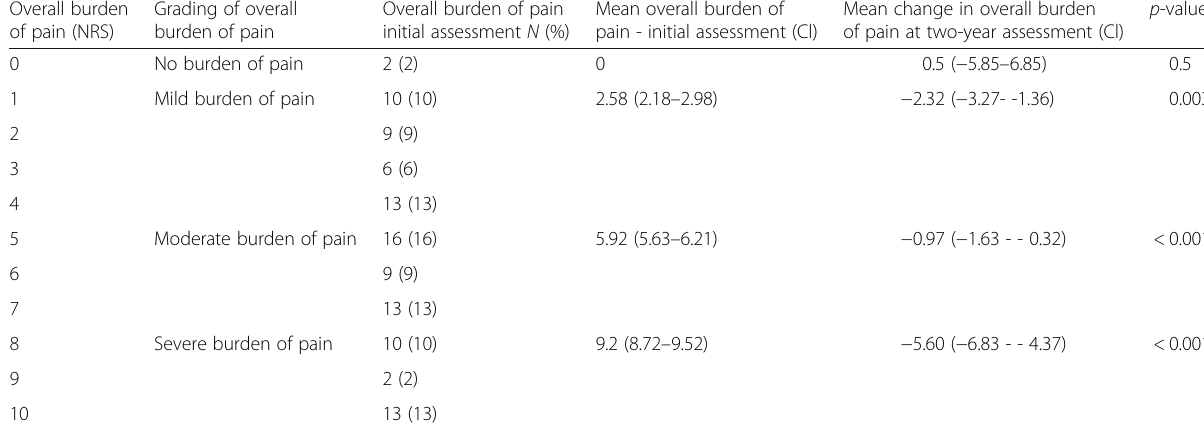
Table 2 Changes in overall burden of pain over the last month according to Numeric Rating Scale Overall burden Grading of overall of pain (NRS) burden of pain